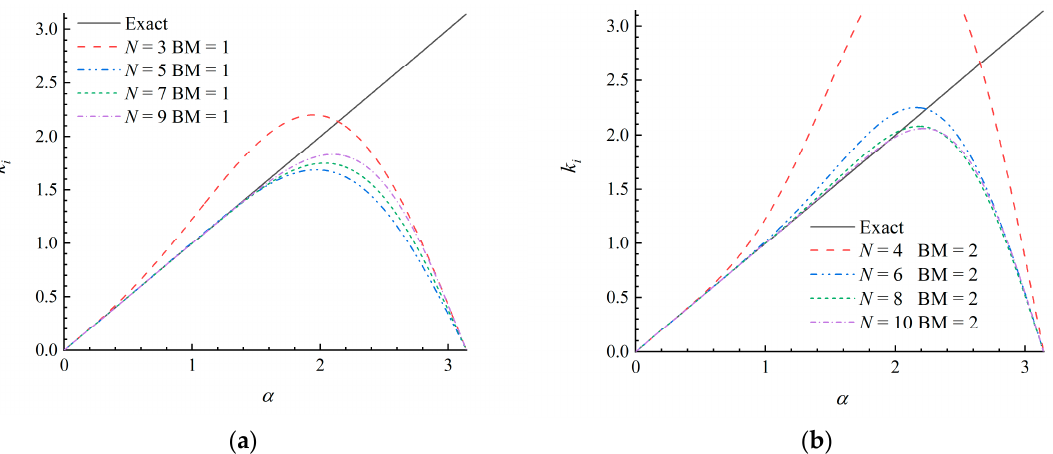
Figure 8. Dispersion coefficients against α in different wavelet schemes: ( a ) N ∈ odd; ( b ) N ∈ even. Table 4. The maximum α for the different schemes.